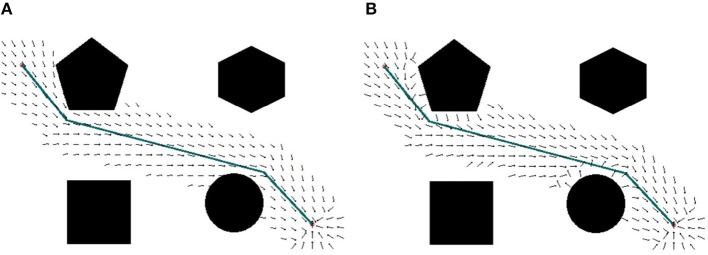
The representation of the static flow field (unity vectors), (A) the initial path with the configured static attractive field, (B) the static flow field with added repulsive force to the obstacles.